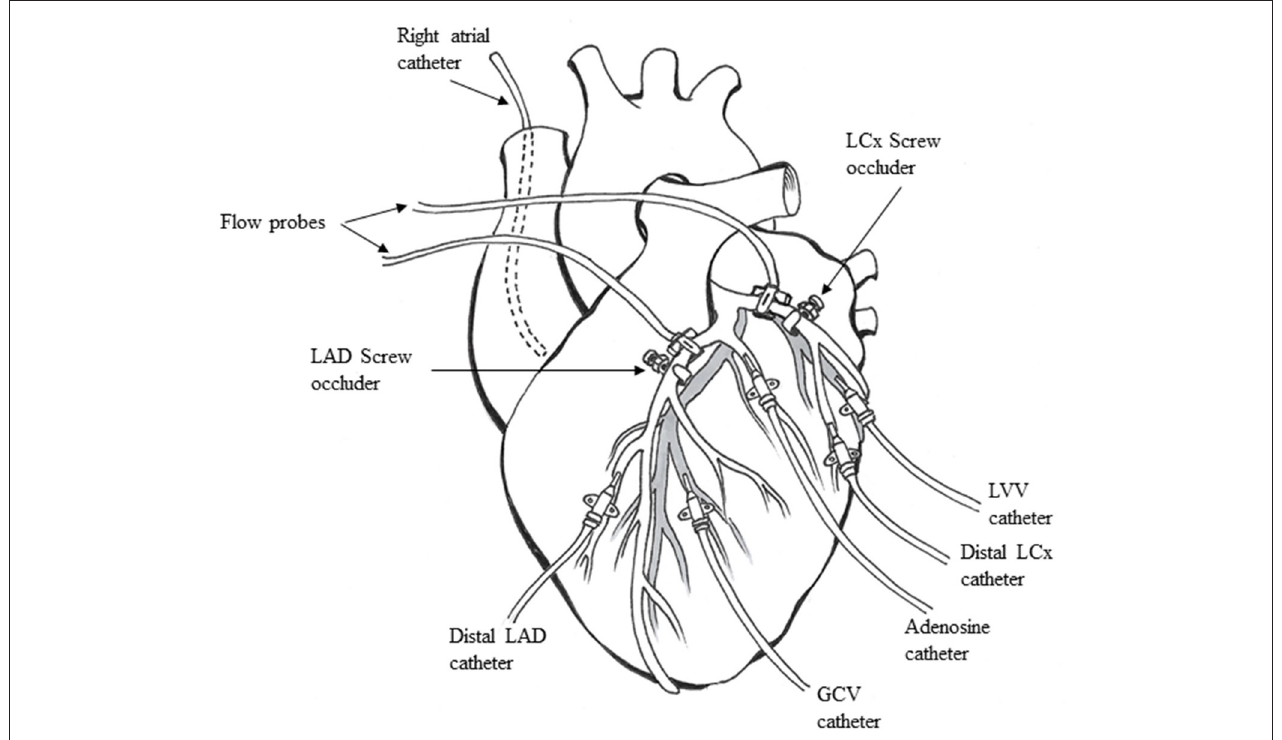
FIGURE 1 | Animal preparation used for the experiments (see text for details). LAD, left anterior descending coronary artery; LCx, left circumflex coronary artery; GCV, great coronary vein; LVV, left ventricular